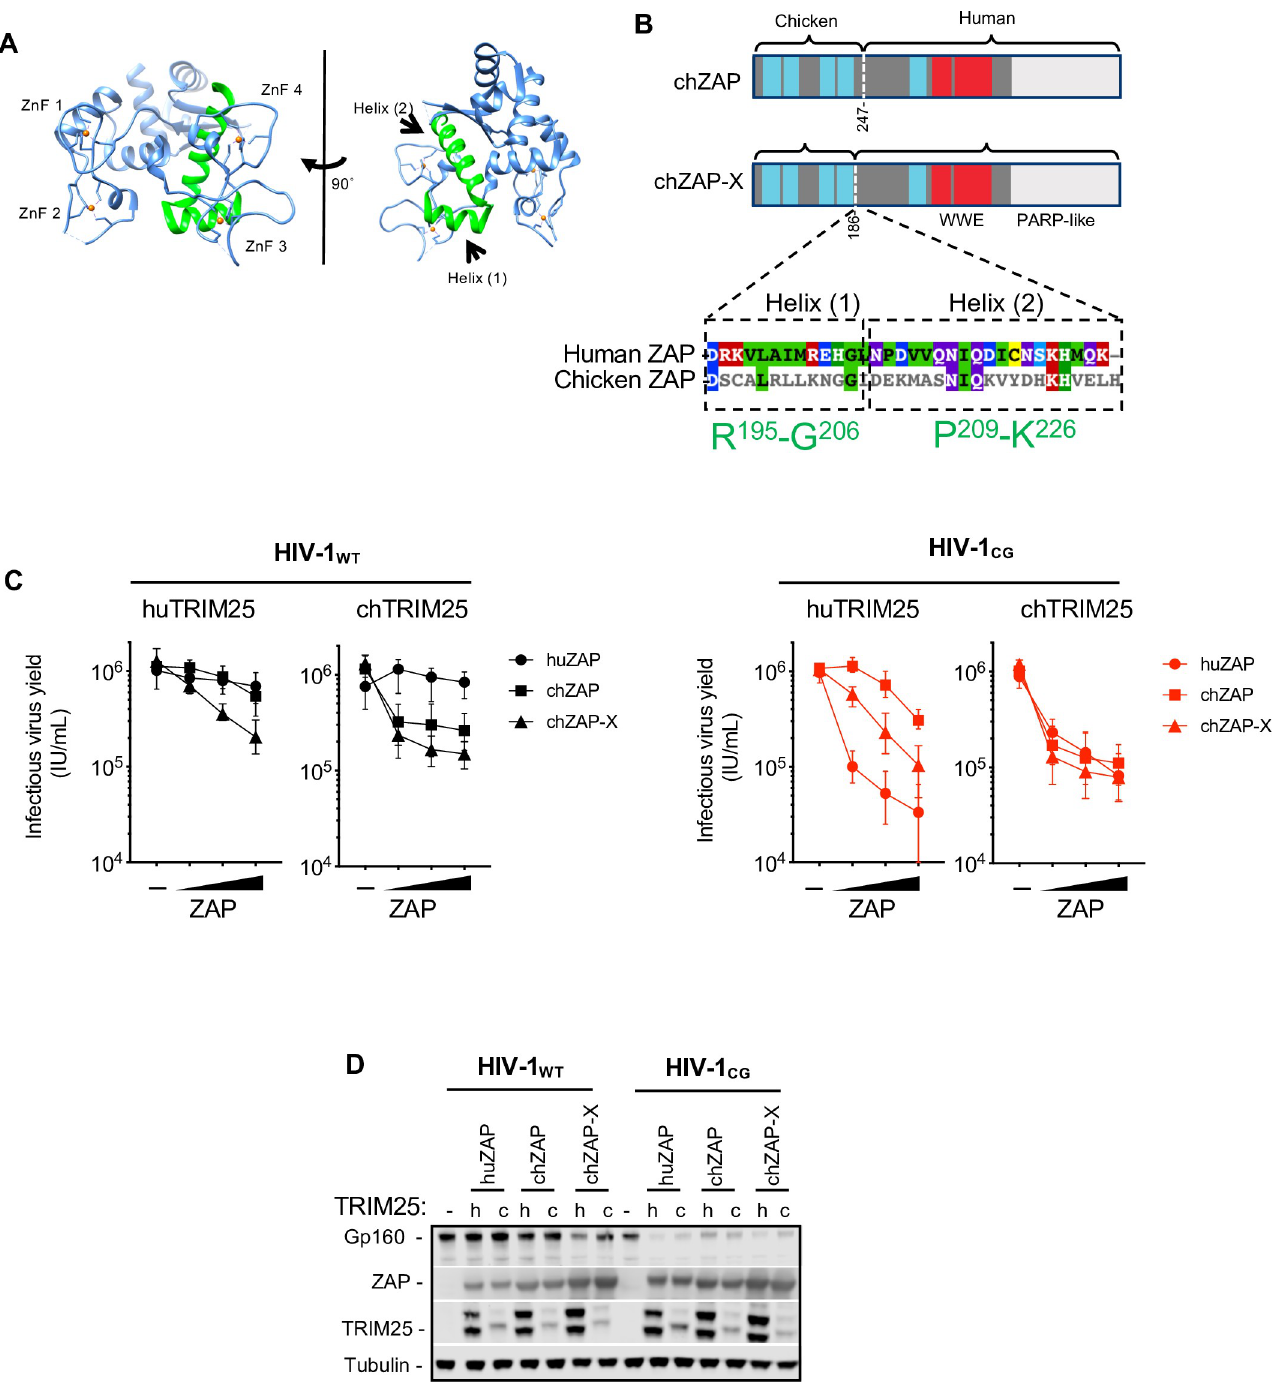
Fig 9. A determinant in the ZAP NTD contributes to the species-specific cognate TRIM25 requirement. (A) Representation of the crystal structure of the RNA-binding NTD domain of human ZAP (PDB 6UEI, [12]). ZnF 1–4 indicate zinc fingers 1 through 4. Areas colored in green indicate α -helices 1 and 2 at the C-terminus of the NTD. (B, top) Schematic diagram of chicken ZAP (chZAP) chimera, containing the N-terminal 247 amino acids of chicken ZAP, in an otherwise human ZAP background, and chicken ZAP-X (chZAP-X) chimera, that contains the N-terminal 186 amino acids of chicken ZAP in a human ZAP background. chZAP-X contains the two human α -helices highlighted (A). (B, bottom) Sequence alignment of the α -helices 1 and 2 in human ZAP with the corresponding region in chicken ZAP. Colors indicate amino acid identity and conservation. The position numbers for the two α -helices in humanZAP are indicated in green. (C-D) HEK293T ZAP -/- and TRIM25 -/- cells were co-transfected with HIV-1 WT and HIV-1 CG proviral plasmids, as well as plasmids encoding human ZAP (huZAP), chicken ZAP chimera (chZAP) and the chicken ZAP-X (chZAP-X) chimera and either human TRIM25 or chicken TRIM25. After 48h,